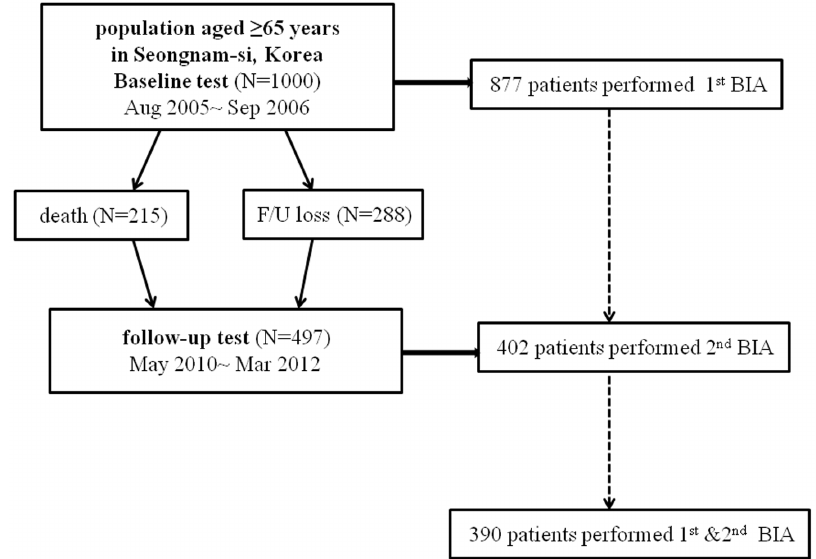
Figure 1. Identification of study participants.